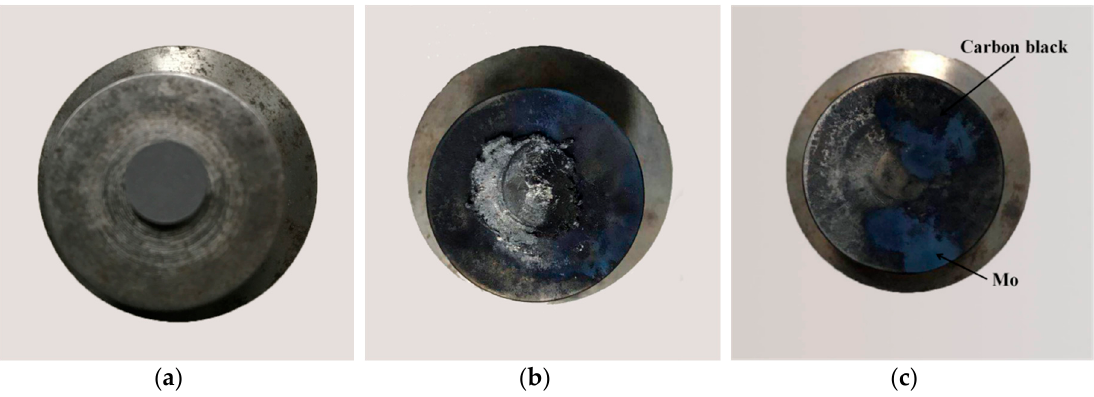
Figure 13. Typical photographs of the PTFE/Al/MoO 3 specimens. ( a ) before reaction; ( b ) and ( c ) after reaction.